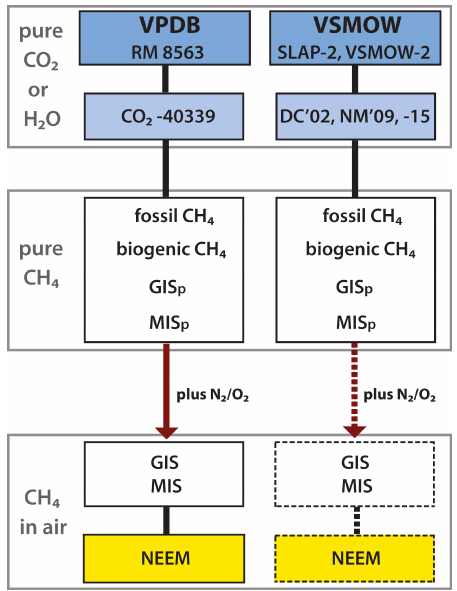
Fig. 2. Shown are the relations of measurements to the VPDB and VSMOW isotope scales in a top-down hierarchy. The dark blue boxes represent the isotope scales and name the international measurement standard used to reference our isotope reference materials, shown in light blue boxes. These isotope reference materials were used to reference the pure CH 4 gases to the respective isotope scale. The red arrows indicate the step where GIS and MIS are produced by diluting the referenced GIS p and MIS p with CH 4 free air, respectively. The yellow boxes in the bottom line represent the sample level. NEEM was referenced according to this reference scheme and is thus anchored to the isotope scales via the respective hierarchy of isotope reference materials. GIS, MIS and NEEM could not be referenced to the VSMOW scale because the GC-IRMS setup is not prepared for isotope measurements of δ 2 H on CH 4 in air (therefore indicated by arrows and boxes in dashed lines). Grey boxes group the type of measurement standards, isotope reference materials and gas mixtures.